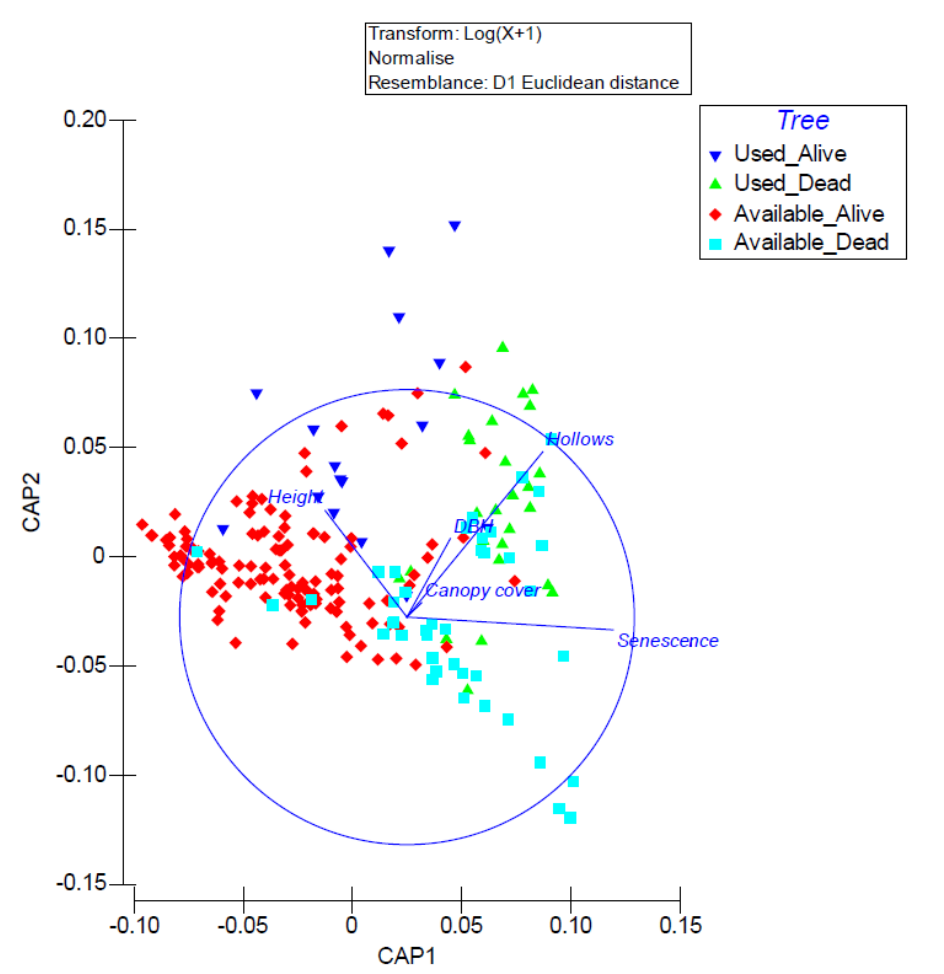
Figure 5. Canonical analysis of principal coordinates illustrating the importance of tree characteristics of N . corbeni roost and available trees. Green triangle = dead tree roosts; blue inverted triangle = living tree roosts; blue square = dead tree available for roosting; red diamond = living tree available for roosting.